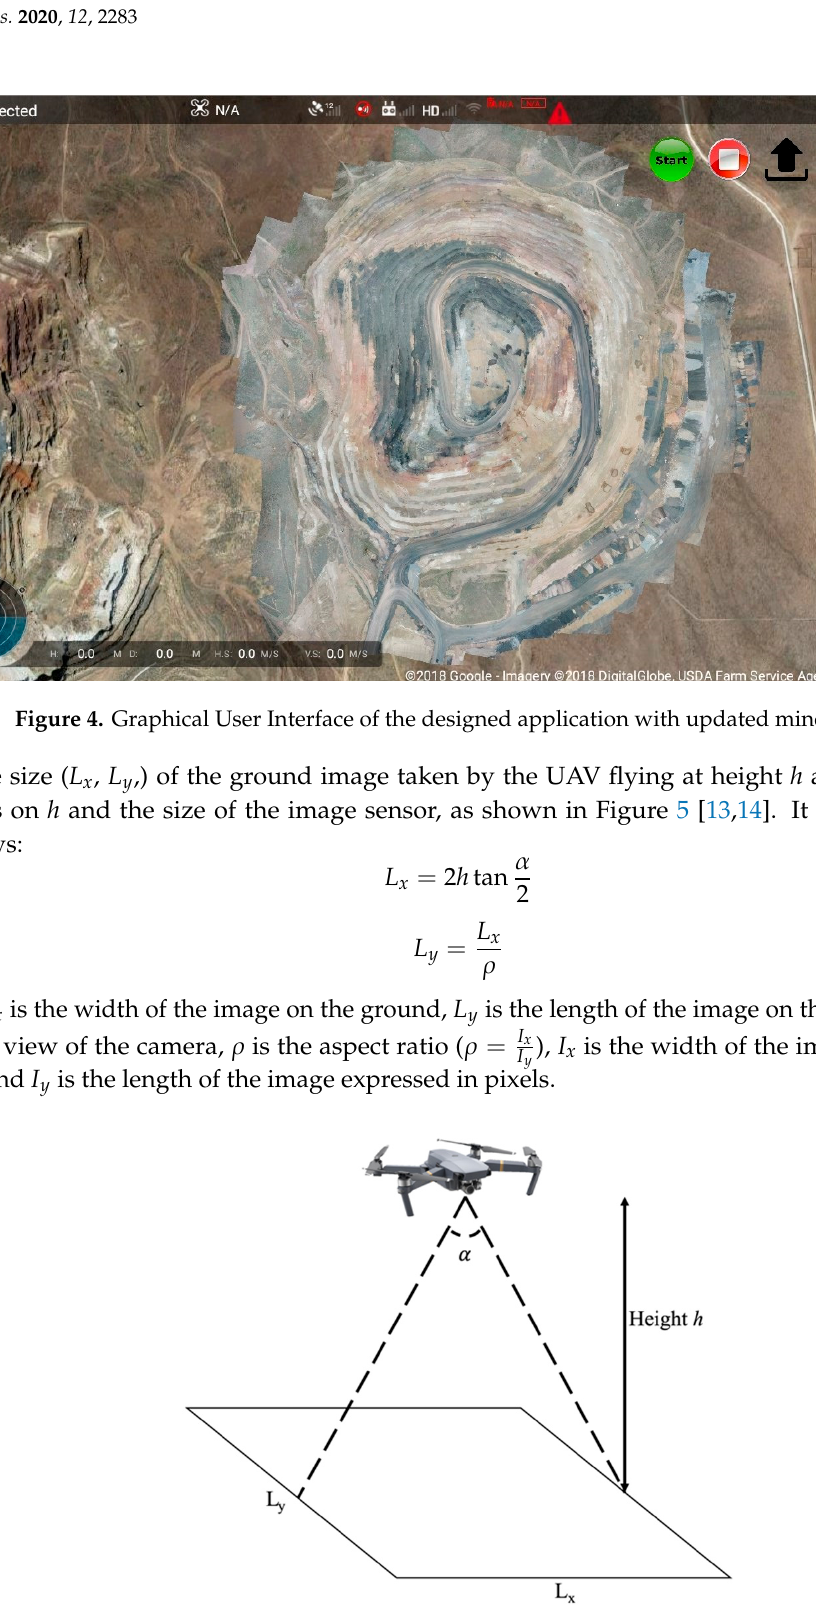
Figure 5. Area projected by a camera with the angle of view α flying at altitude h (i.e., area of ground that is visible through the camera at a particular position and orientation).